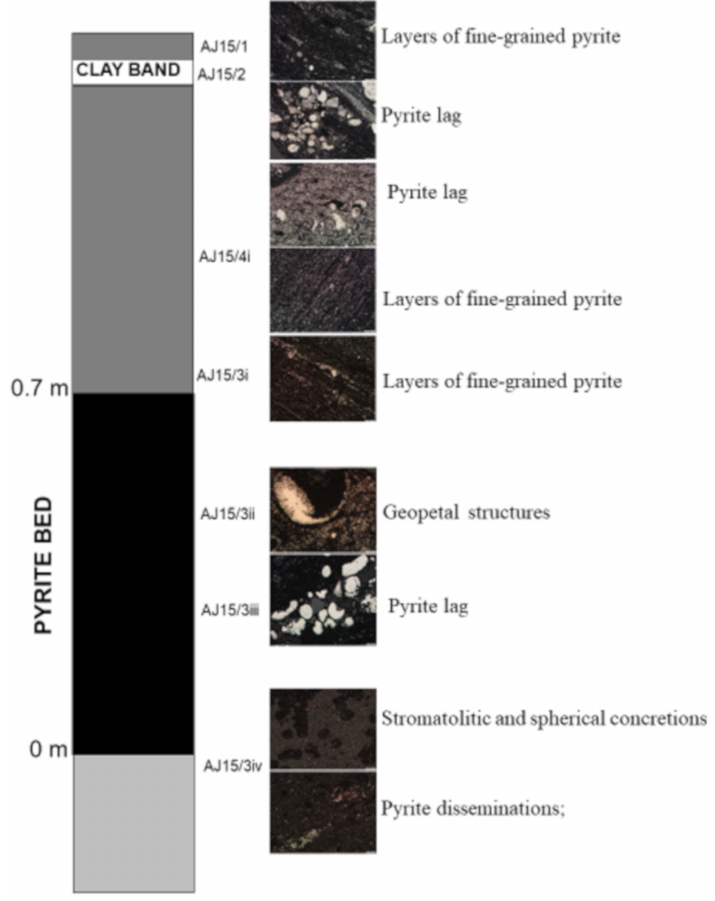
Figure 8. Textural variation observed